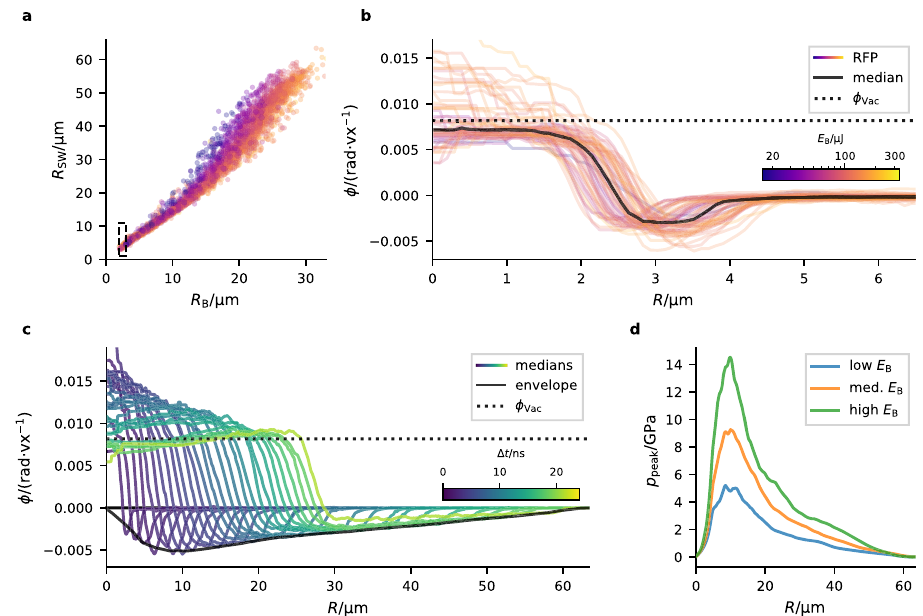
Fig. 4 Cavitation dynamics. a Radius of bubble and shockwave boundary R B and R SW . Each scatter dot represents one processed cavitation event. The color scales with the bubble ’ s energy (shared colorbar with ( b ), logarithmic scale). b Radial 3d phase pro fi les ϕ ( R ) of cavitation events with 2 – 3 μ m bubble boundary radius (dashed box in ( a )). The radial phase was reconstructed from the RFP phases ϕ . The color represents E B . The median of all phase distributions is shown in black. The phase shift of vacuum to water ϕ vac is shown for comparison. c Median of phase pro fi les for different ranges of R B , showing how the median phase evolves with time. Here, only cavitation events with E B between 66 and 130 μ J were used. The color represents the median of the time delay Δ t . The (smoothed) envelope of the shockwave ’ s phase shift (black) is used to calculate the shockwave ’ s peak pressure p peak as a function of the distance to the bubble center R . d p peak ( R ) obtained from the envelope of the shockwave ’ s phase shift for energy ranges E B between 7 and 66 μ J (low E B ), 66 and 130 μ J (med. E B ) and 130 – 250 μ J (high E B